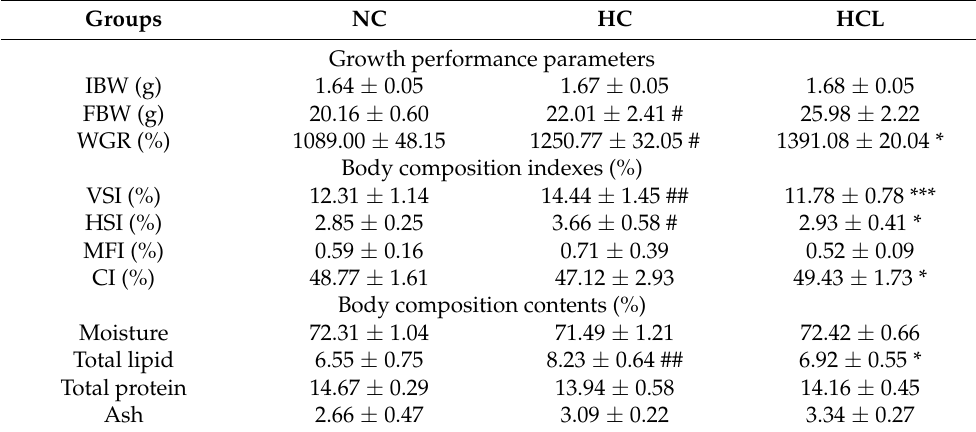
Table 1. Effect of L. plantarum MR1 on growth performance parameters, body composition indexes, and body composition contents of Nile